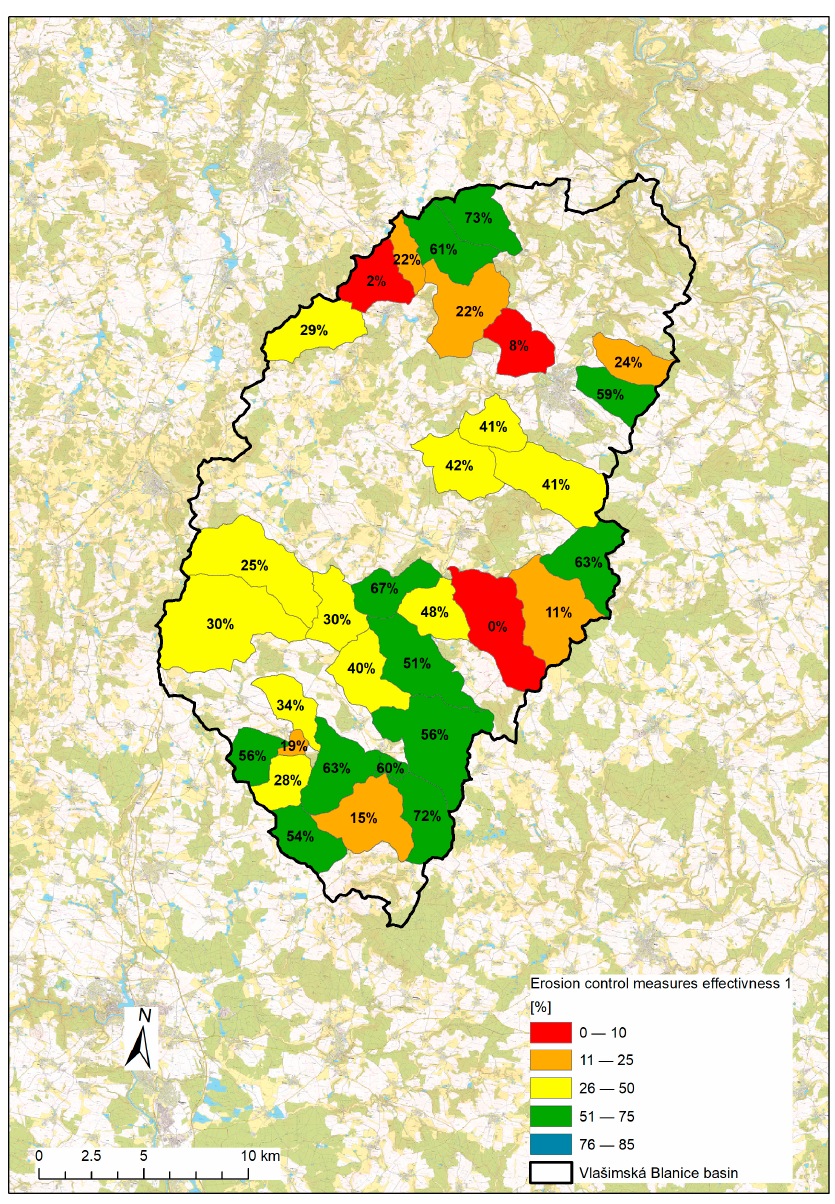
Figure 5. Assessment of erosion control measures of effectiveness 1 in terms of sediment